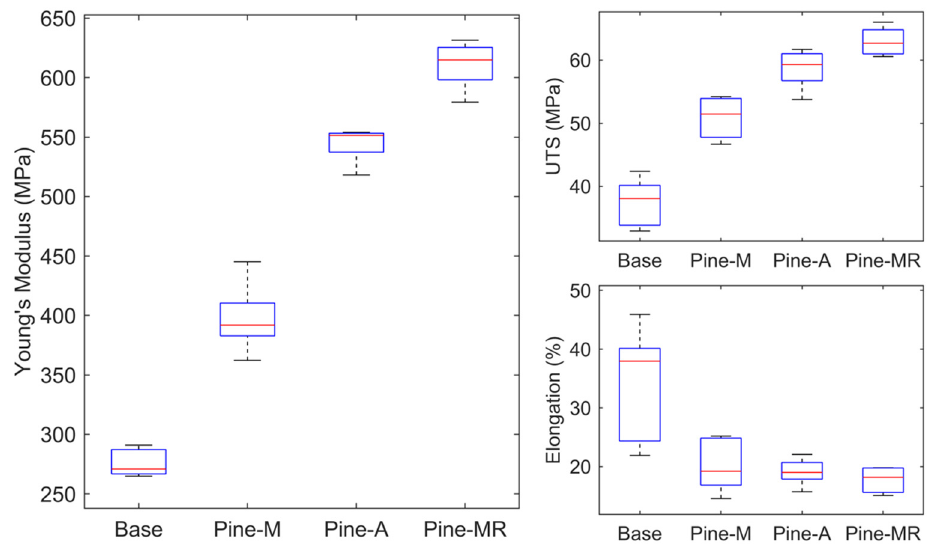
Figure 5. Young’s modulus ( left ), ultimate tensile strength ( top right ), and percent elongation ( bottom right ) for the casted base and lignin resins.